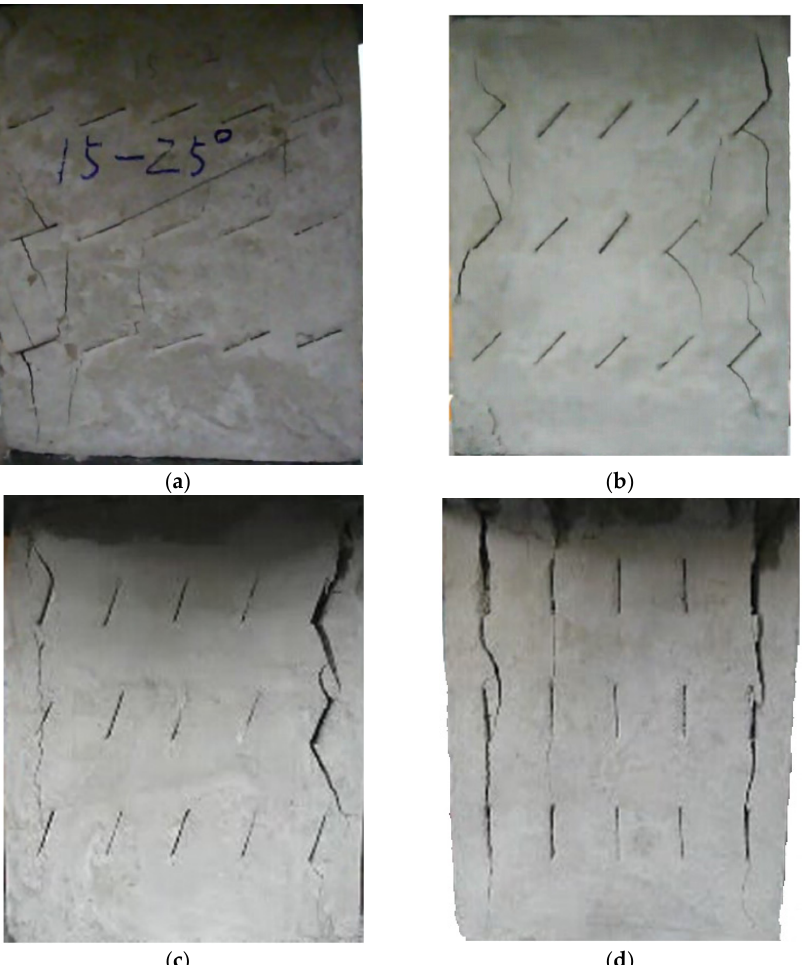
Figure 8. The failure process with 15 cracks. ( a ) 25°; ( b ) 45°; ( c ) 75°; ( d ) 90°.